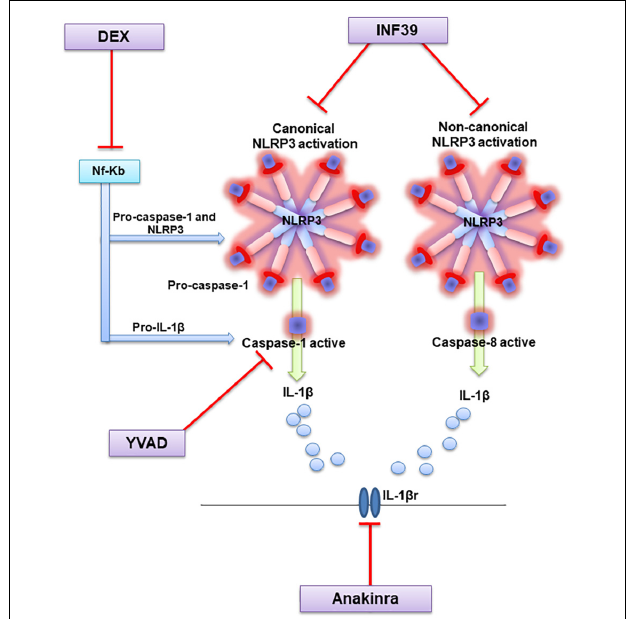
FIGURE 5 | Diagram showing the molecular mechanisms through which test drugs may inhibit NLRP3 signaling and counteract intestinal